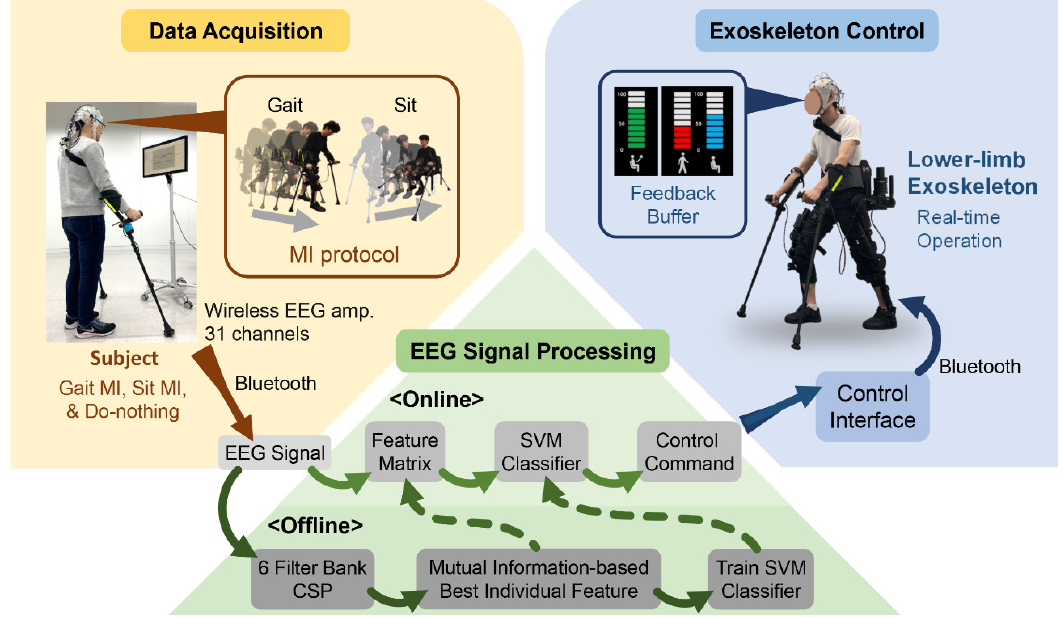
Figure 1. A diagram of the motor imagery (MI)-based brain-computer interface (BCI) exoskeleton control system.